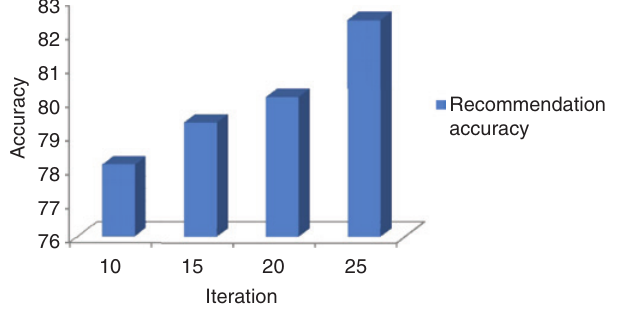
Figure 4: Graphical Representation of Recommendation Accuracy for Our Proposed Research.